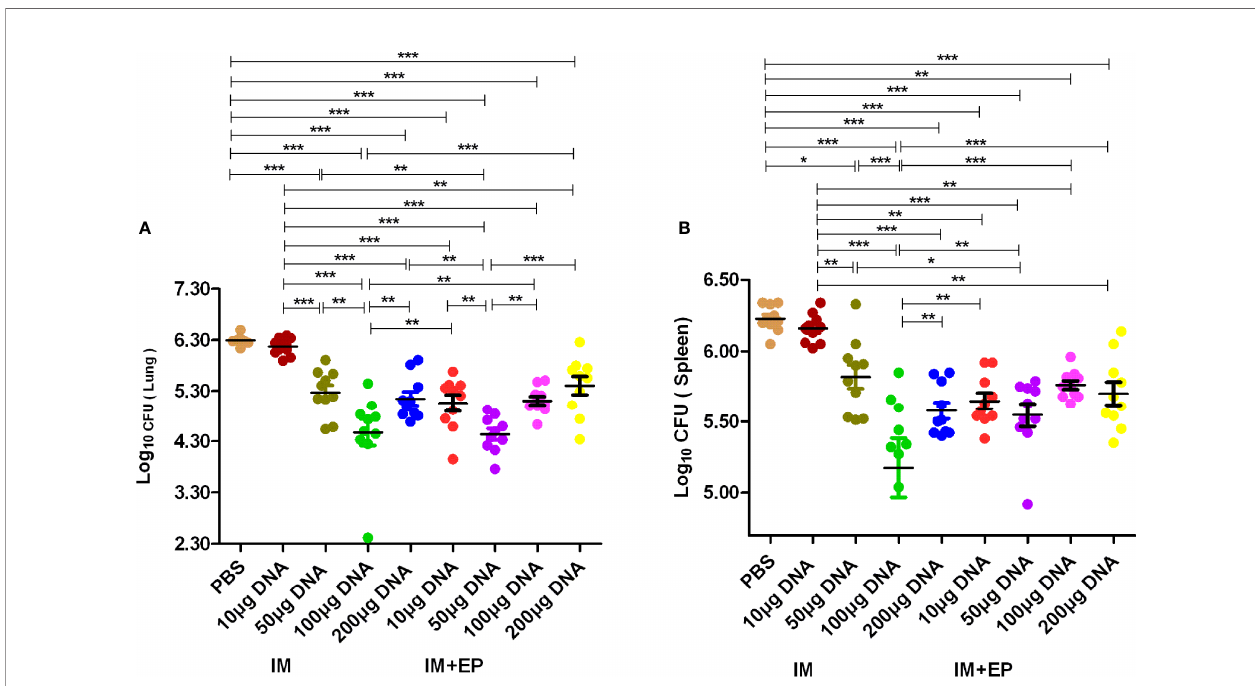
FIGURE 4 | The numbers of live bacteria in lungs (A) and spleens (B) at 17-18days after the third immunization. The data are expressed as the mean% ± standard deviation (n = 10) from 10 mice in each group. IM, intramuscular injection; EP, electroporation. * P < 0.05, ** P < 0.01, ***P < 0.0001.